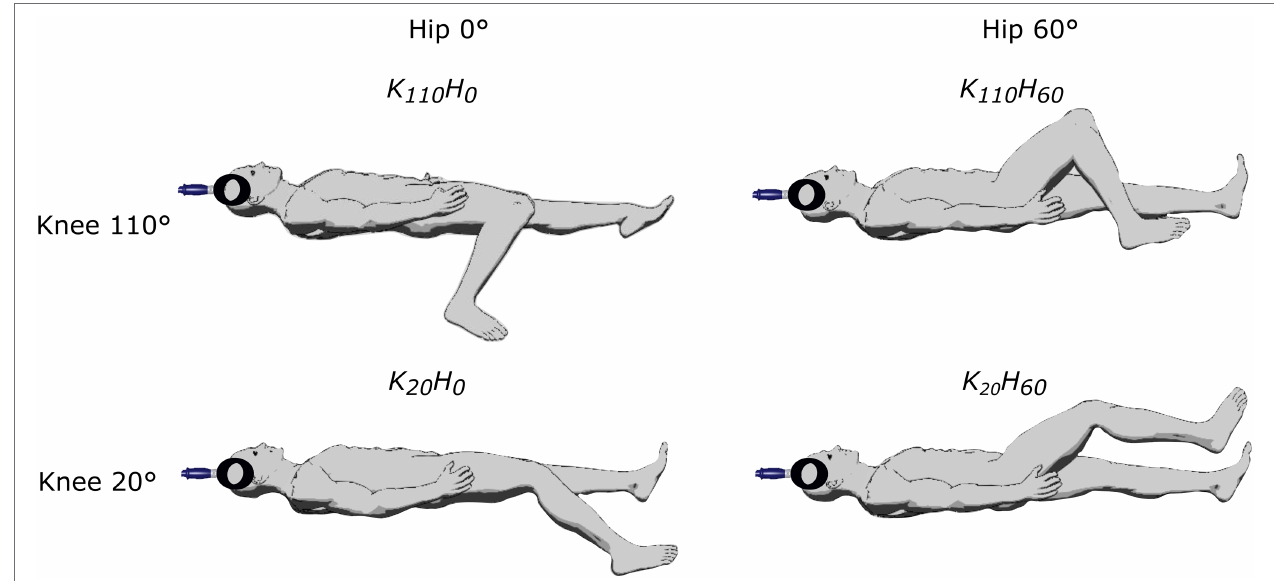
FIGURE 1 | Description of the different positions tested in the experimental protocol by adjusting knee flexion (20 ° or 110 ° ) and/or hip flexion (0 ° or 60 °